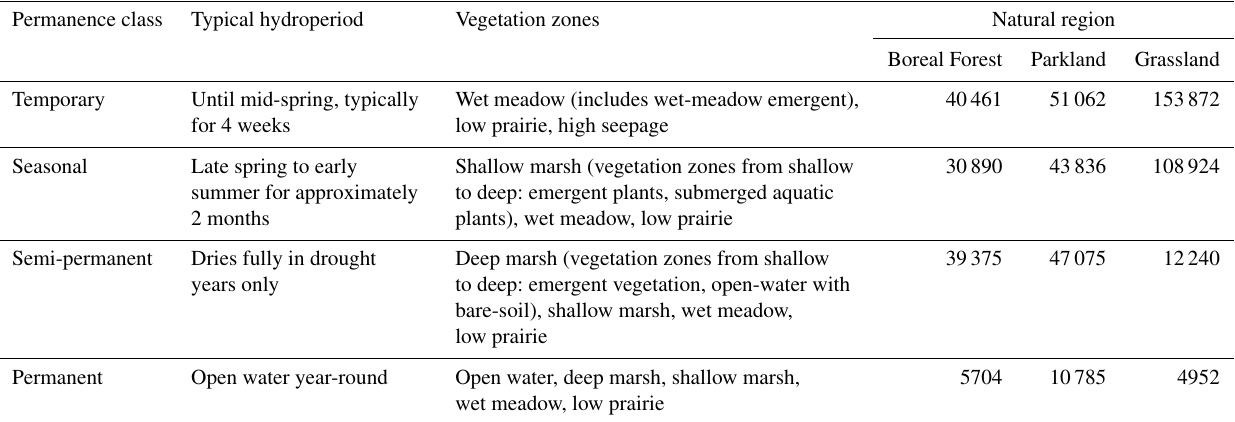
Table 1. Descriptions of the four permanence classes included in our study. We describe the typical length of time that these prairie pothole wetlands will contain ponded water, their associated vegetation zones, as described by Stewart and Kantrud (Stewart and Kantrud, 1971), and the number of wetlands belonging to each class in the Alberta Merged Wetland Inventory (Government of Alberta, 2014) that were within the extent of our 25m digital elevation